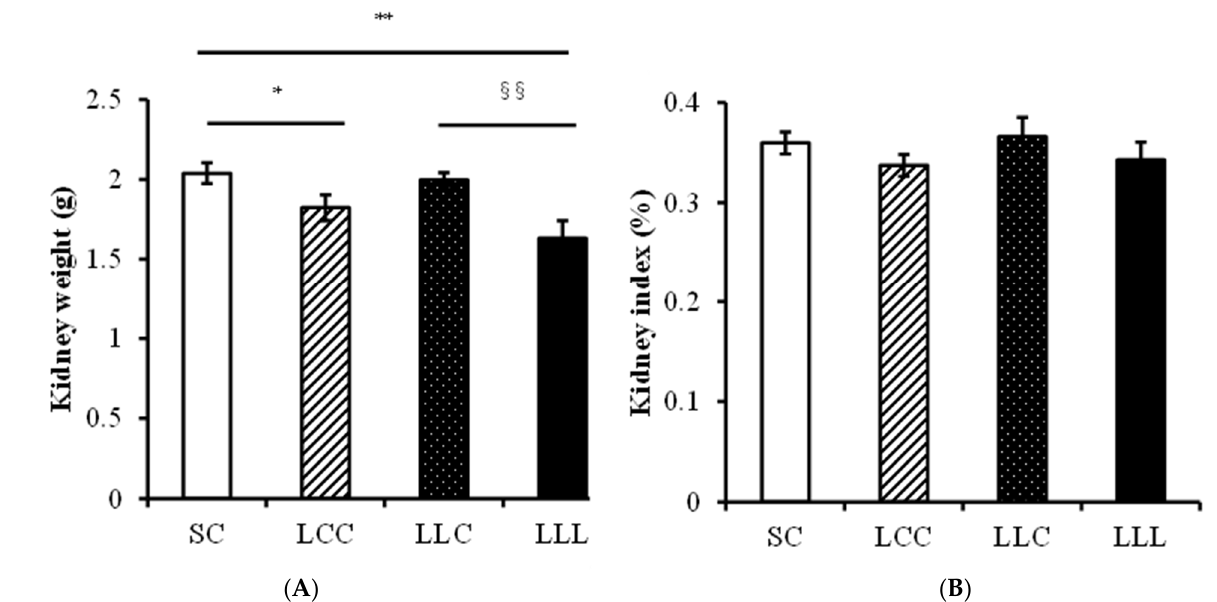
Figure 2. Kidney weight and index. ( A ) The left kidney weight ( B ) The kidney index. Four groups were evaluated by one-way ANOVA with the LSD post hoc test. * vs. SC, p < 0.05; ** vs. SC, p < 0.01; §§ vs. LLC, p < 0.01.